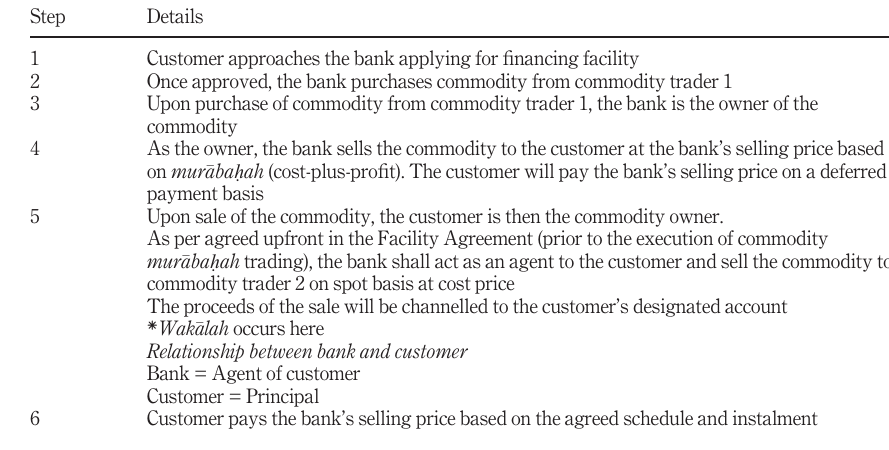
tawarruq -based fi